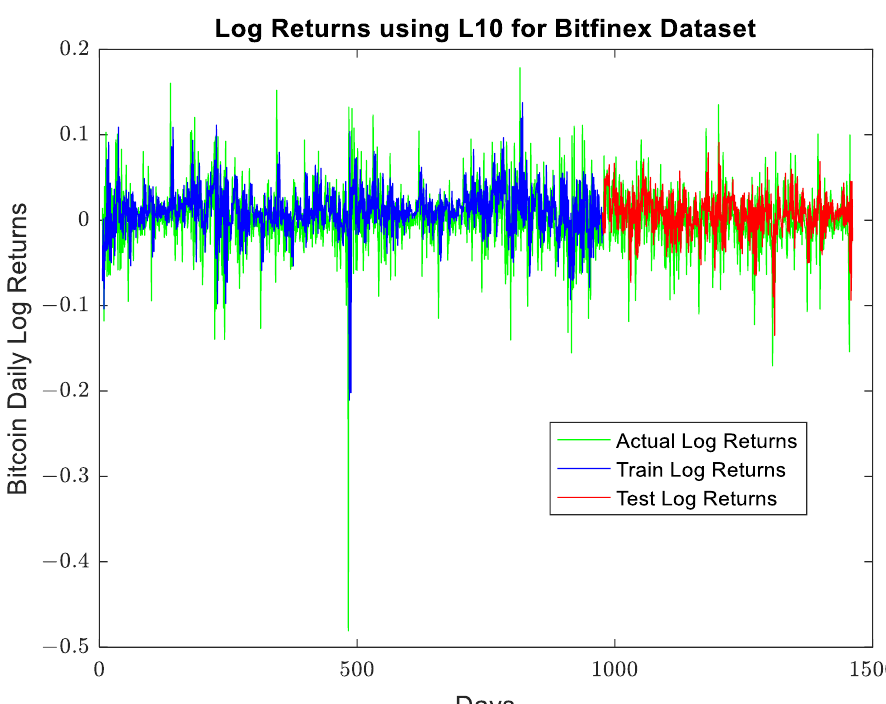
Figure 14. Training, testing and actual Bitcoin log returns of Legendre based neural network model using proposed dual normalized Bitfinex dataset.